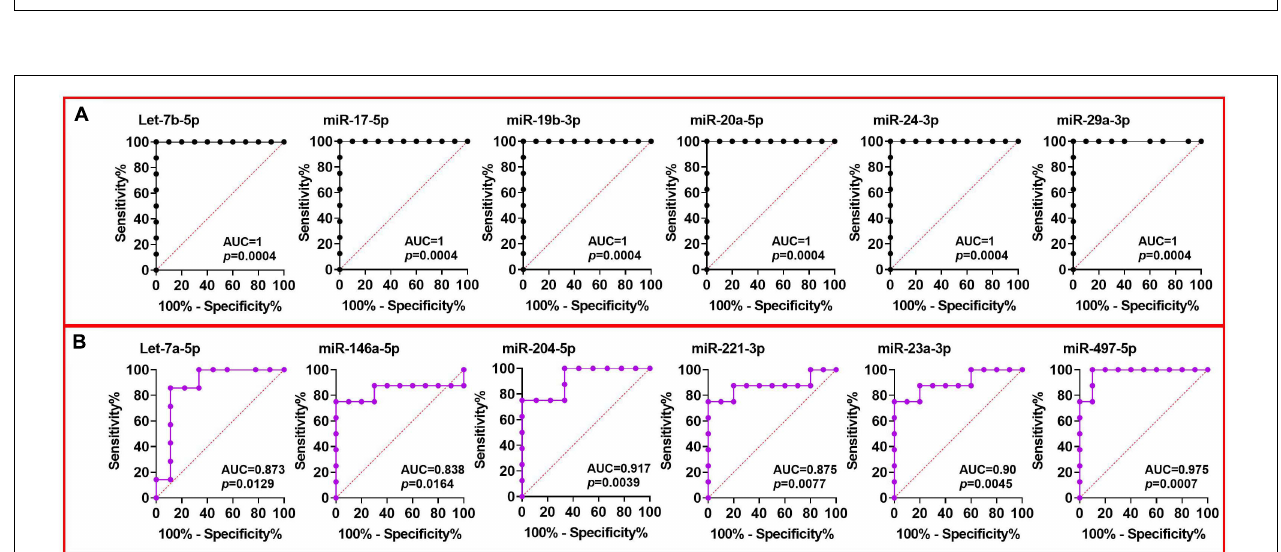
FIGURE 5 | ROC analysis of miRNAs using Group A CSF and plasma data collected at PBD3 from aSAH patients. ROC curve constructed using (A) DCV+ and DCV– groups of CSF miRNA data; (B) DCV+ and DCV– groups of plasma miRNA data.